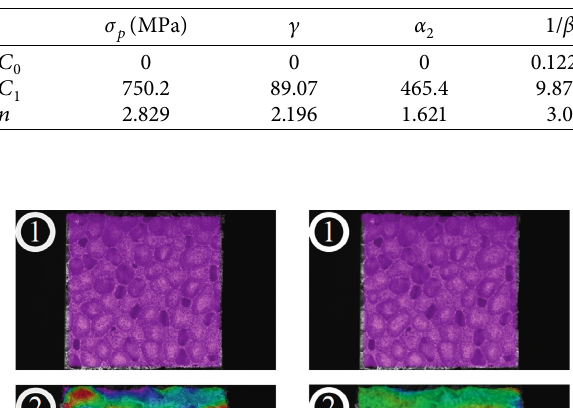
, C , and n in equation (13). 0 1